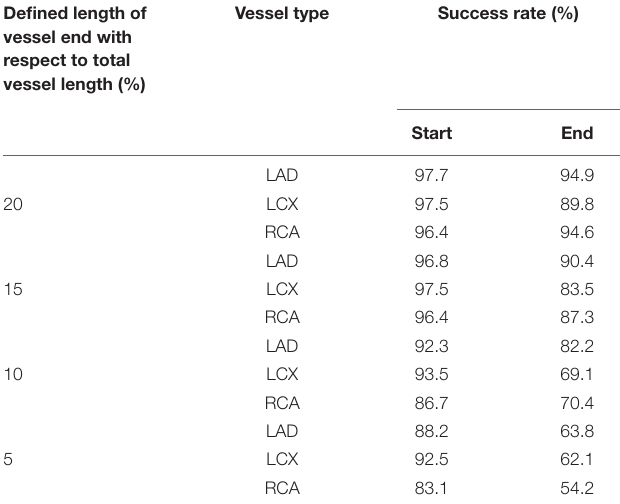
TABLE 1 | Success rates of pointing the vessel ends by the deep learning network. Defined length of vessel end with respect to total vessel length